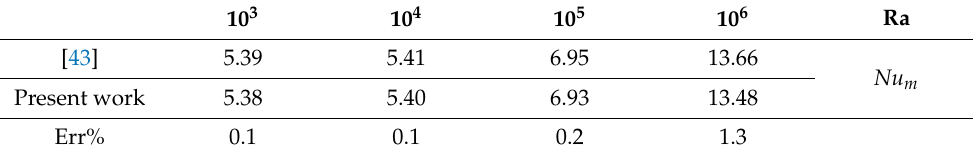
Table 2. Comparing the average Nu values of this study and with different Ra values.